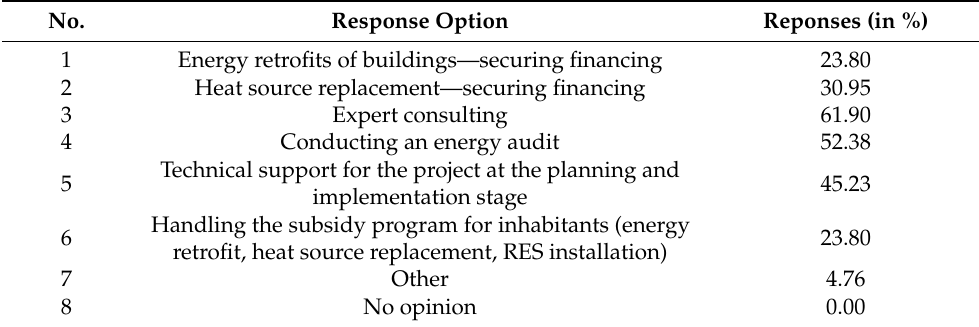
Table 6. Services offered in the ESCO formula. Source: CAWI survey (multiple choice